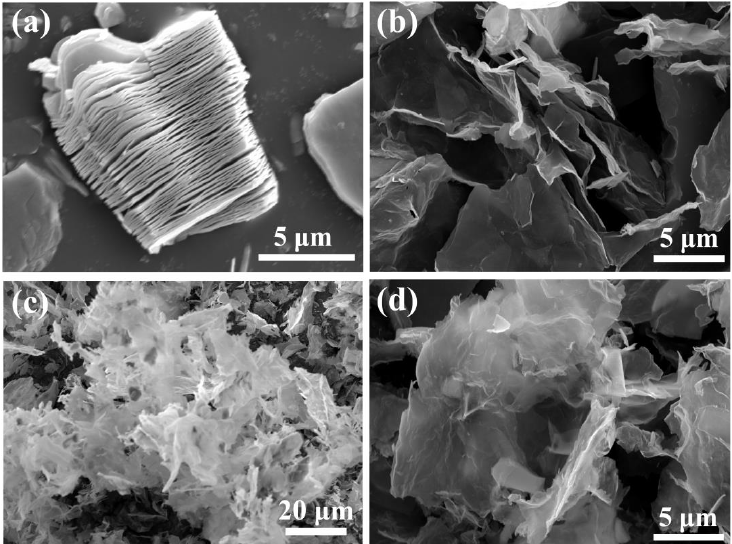
Figure 1. SEM images of ( a ) Ti 3 C 2 T x -F; ( b ) Ti 3 C 2 T x -T; ( c ) and ( d ) Ti 3 C 2 T x -T(O).